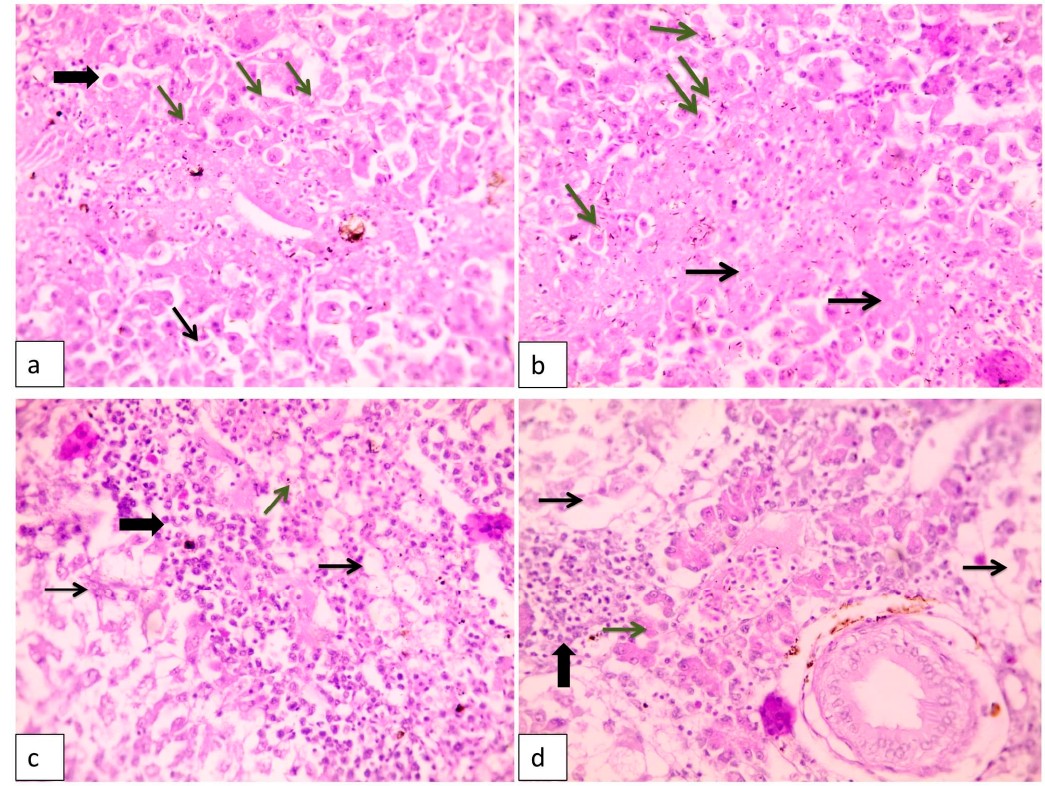
Figure 1. Histopathological lesions in liver of naturally diseased Nile tilapia showing ( a ) hepatocellular dissociation (thin arrow) with many necrotic and apoptotic cells (thick arrow). Few rod-shaped bacteria are inside a hepatocyte cytoplasmic vacuole (green arrows). H&E (hematoxylin and eosin), 400×; ( b ) Widespread hepatocellular necrosis (black arrows) with diffuse, numerous rod-shaped bacteria (green arrows). H&E, 400×; ( c ) Diffuse, severe necrotizing hepatitis. See widespread, severe hepatocellular lysis (arrows) with few bacteria (green arrow) and widespread infiltrations with numerous macrophages and lymphocytes (thick arrow). H&E, 400×; ( d ) Hepatopancreatitis with edema widely separated lytic hepatocytes (arrows) and lysis of hepatopancreas (green arrow) and focal aggregations of inflammatory cells (thick arrow).